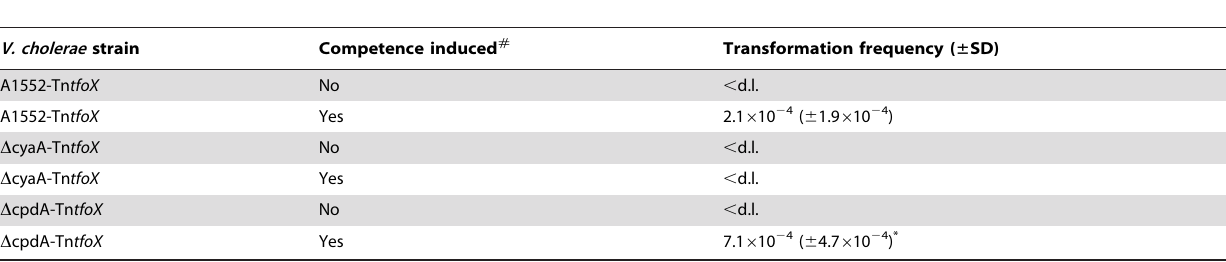
Table 2. Natural transformation is dependent on cAMP, which is produced by adenylate cyclase (CyaA) and degraded by cAMP- degrading phosphodiesterase (CpdA).